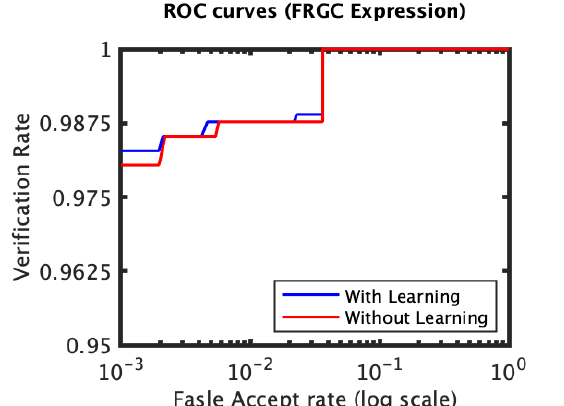
Figure 4. The ROC curves for the non-neutral subset of the FRGC dataset which were spared for evaluation (RAIK